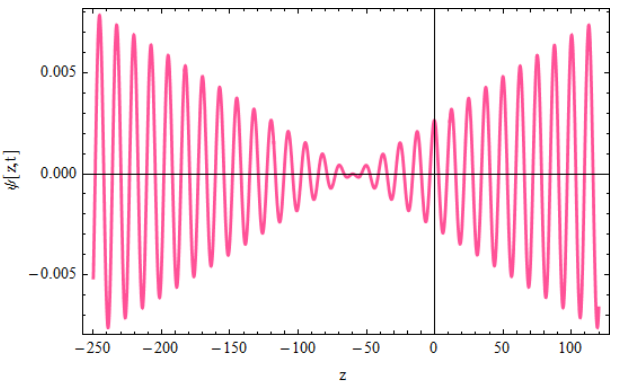
Figure 7. Change of real part of solution (19) with z , t for c = 0.5, v = 0.7, β 1 = 0.05, β 2 = 1, β 3 = 0, β 4 =